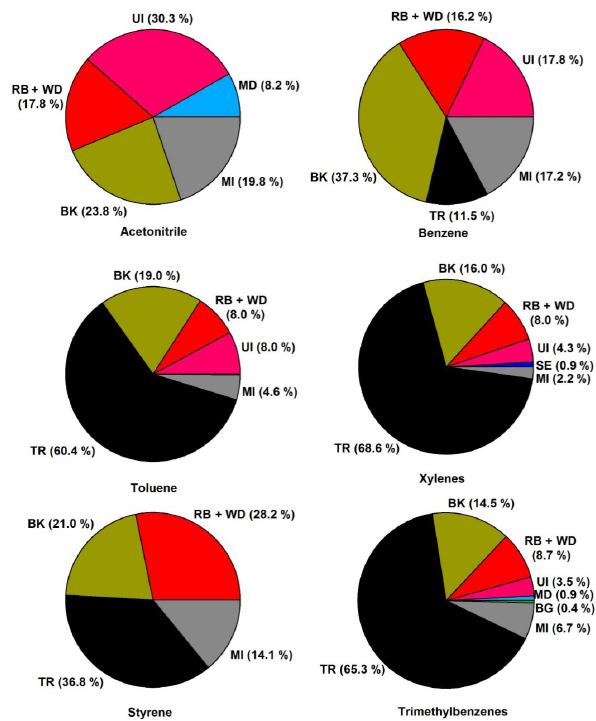
Figure 15. Contribution of PMF-derived source factors to acetoni- trile and aromatic NMVOCs. Source names are abbreviated as fol- lows: MD is mixed daytime, MI is mixed industrial, UI is unre- solved industrial, BK is brick kiln, TR is traffic, RB is residential burning and waste disposal, SE is solvent evaporation, and BG is